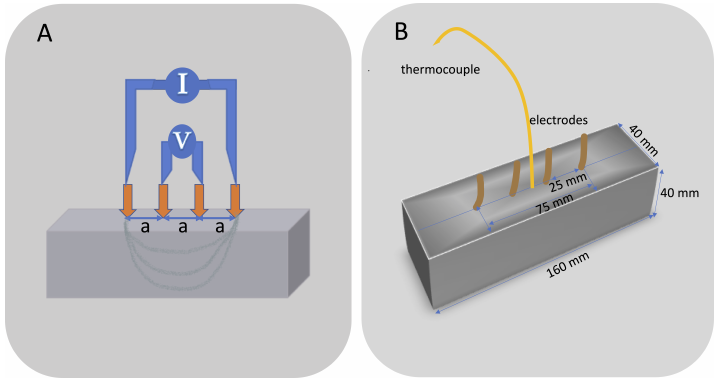
Figure 2. Diagram of Wenner method for resistivity measurements in mortar specimens ( A ), and ( B ) electrode spacing and